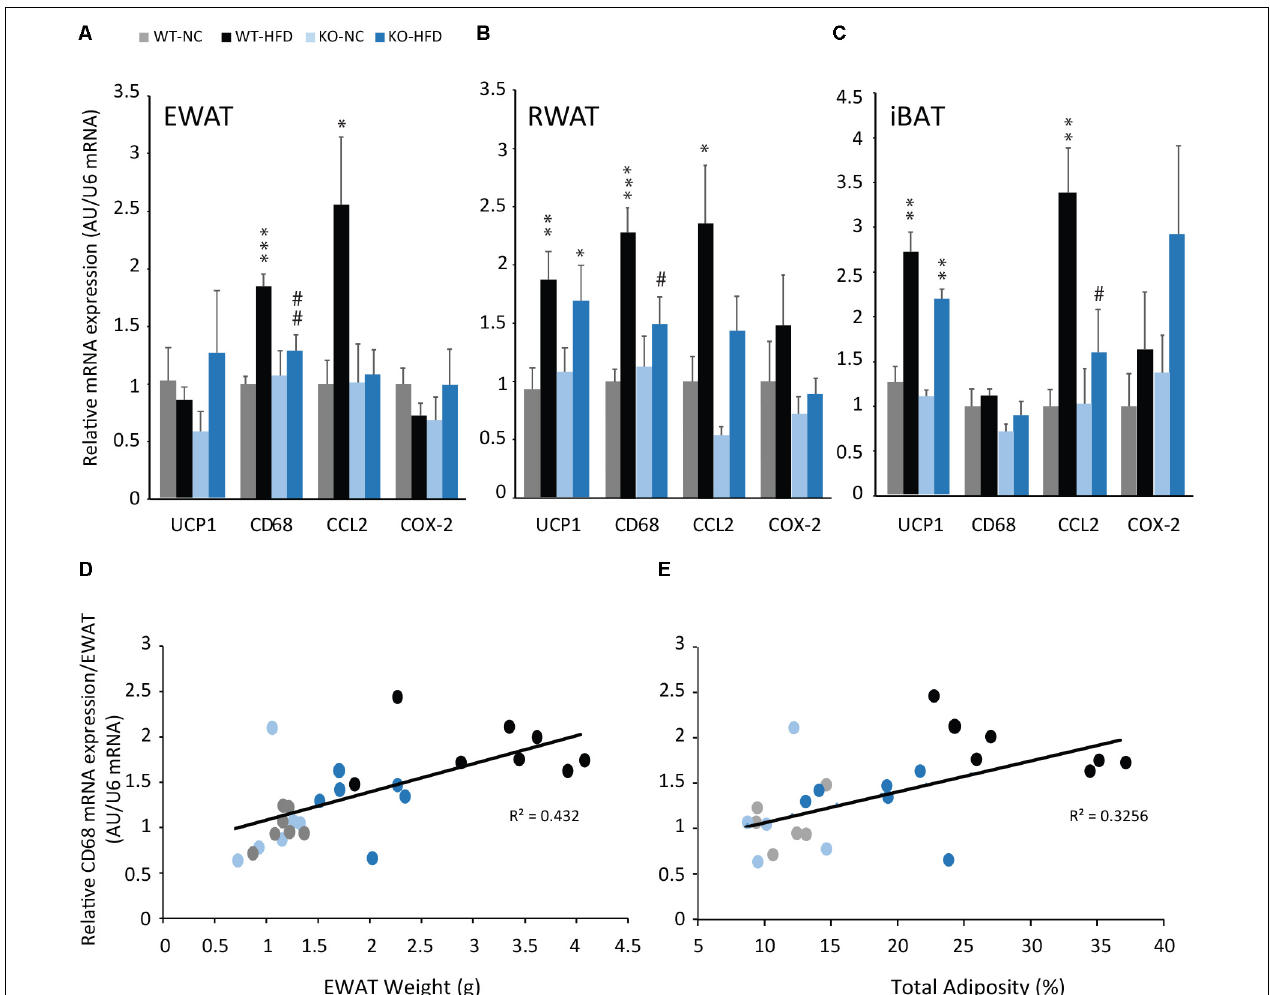
FIGURE 4 | mPGES-1 invalidation reduces HFD-induced adipose tissues inflammation. Real-time PCR analysis of UCP1, CD68, CCL2 and COX-2 mRNA expression in EWAT (A) , RWAT (B) , and iBAT (C) of WT and KO fed either with normal chow (NC) or a high-fat diet (HFD). Correlation analysis were performed on the CD68 mRNA expression and EWAT weight ( D , R 2 = 0.432) and CD68 mRNA expression and total adiposity ( E , R 2 = 0.325). Data shown are mean ± SEM; ∗ , significantly different from NC; # , significant difference between WT-HFD and KO-HFD; ∗ p < 0.05; ∗∗ p < 0.01; ∗∗∗ p < 0.001; and same statistical parameters apply to #